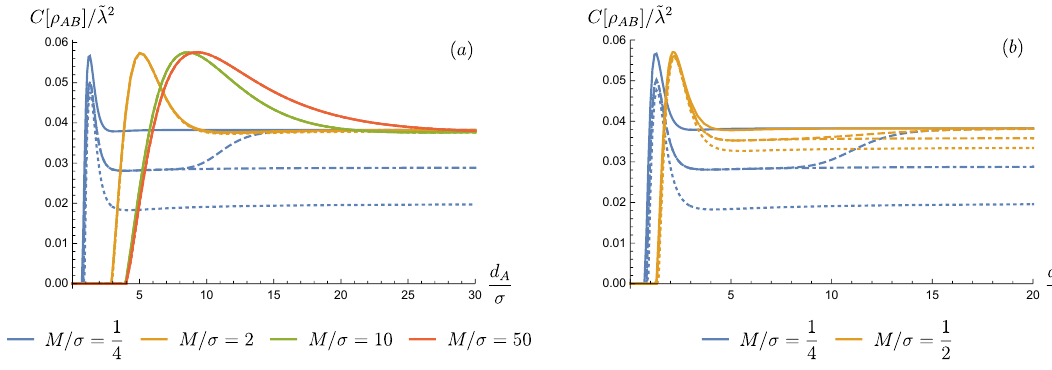
Figure 5 . The concurrence as a function of proper distance of Alice’s detector away from the horizon (in units of (cid:27) ) for di(cid:11)erent black hole masses (in units of (cid:27) ). In both (cid:12)gures, solid is Boulware, dotted is Hartle-Hawking-Israel, dot-dash is Unruh, and dashed is Vaidya. When the curves are indistinguishable, a solid curve is drawn. Here ~ (cid:21) = (cid:21)(cid:27) 1 (cid:0) n 2 = (cid:21) is dimensionless coupling constant and we set (cid:10) (cid:27) = 2, with the two detectors separated by proper distance d ( r A ; r B ) = 2 (cid:27) . The detectors are turned on at (cid:28) 0 = 12 (cid:27) . (a) the entanglement death zone is saturated for large masses, at d A (cid:24) 4 (cid:27) for M=(cid:27) (cid:21) 10, and at large masses the concurrence tends to the zero- temperature Boulware limit. (b) shrinking of the di(cid:11)erence in entangling power between the four vacua as mass increases.